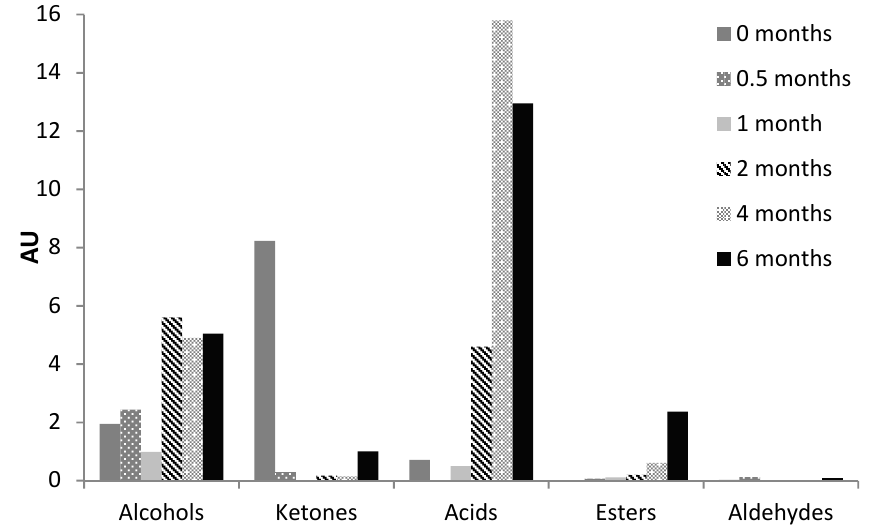
Figure 5. Changes in the content of the main chemical groups of the volatile compounds (AU × 10 4 ) identified during RO-cheese ripening. AU: arbitrary units (peak area).